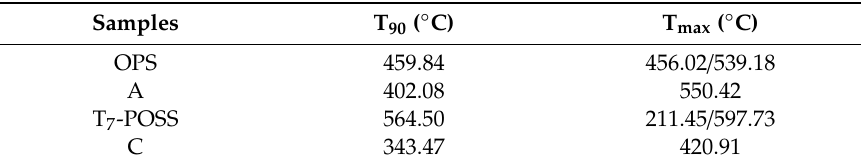
Figure 8. Thermogravimetric analysis (TGA) curves of ( a ) octaphenylsilsesquioxanes (OPS) and sample A, and ( b ) T 7 -POSS and sample C. Table 3. Corresponding data of Figure